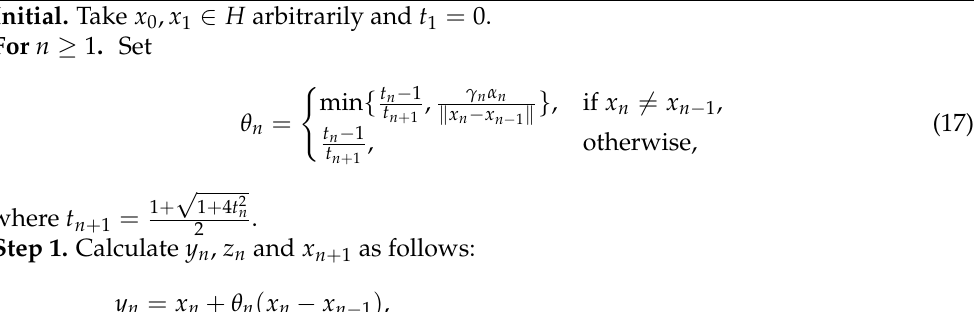
Algorithm 5 An Inertial Bilevel Gradient Modified Picard